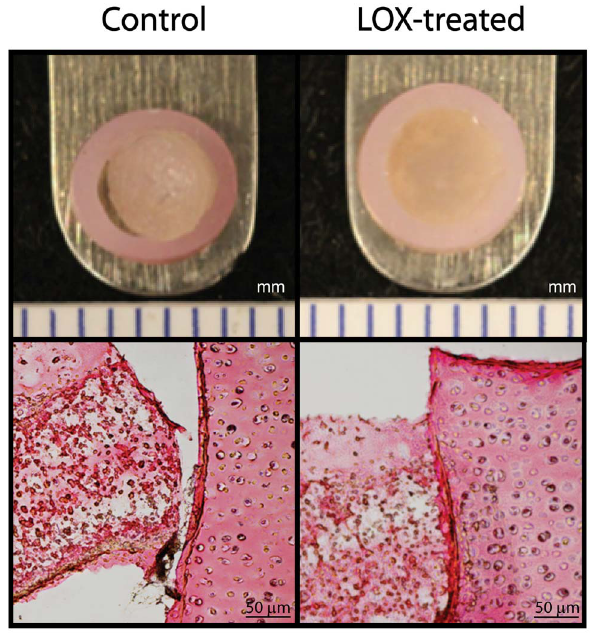
Figure 2. Gross morphology and histology of constructs/ explant assemblies. Straight from culture, most controls resembled LOX-treated samples, though gaps were seen in one-third of the controls (upper left panel). None of the LOX-treated samples displayed gaps that were grossly visible; a representative sample (Group D) is shown (upper right). Gaps in the controls were also seen after histological processing using picrosirius red (lower left) versus LOX- treated samples (lower right, Group